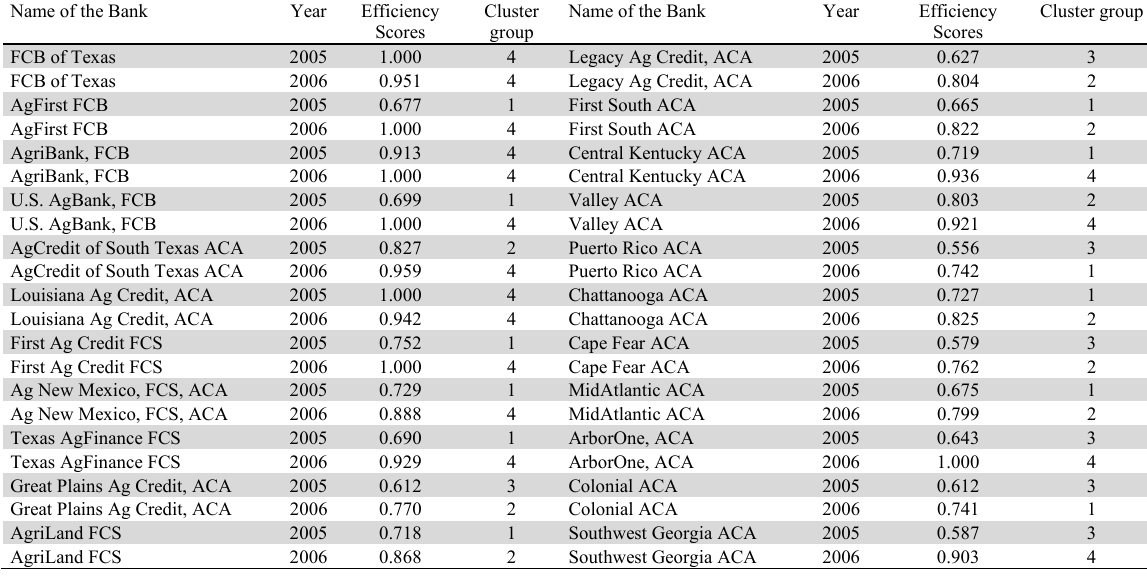
Efficiency Measure Prior (2005-2006) Name of the